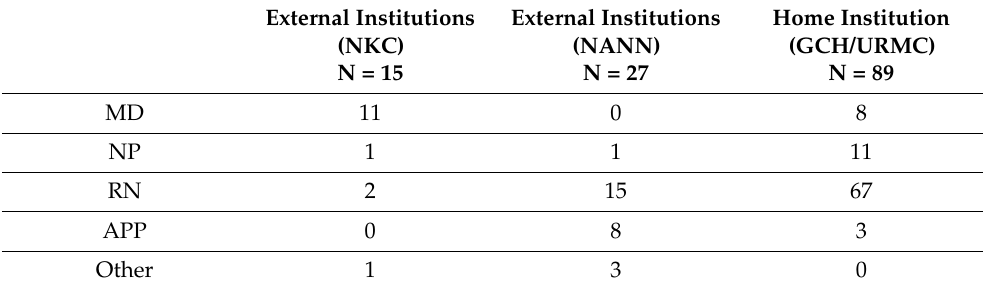
Table 1. Professional distribution of respondents.